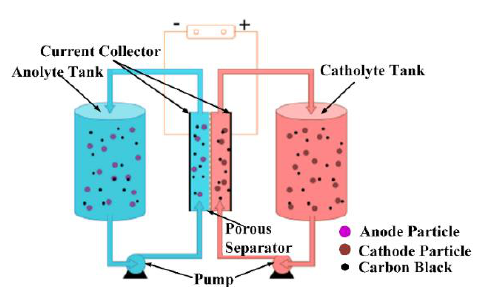
Figure 56. Schematic illustration of Type II RFB design, where the electroactive materials are solid and dispersed in the electrolyte [161].